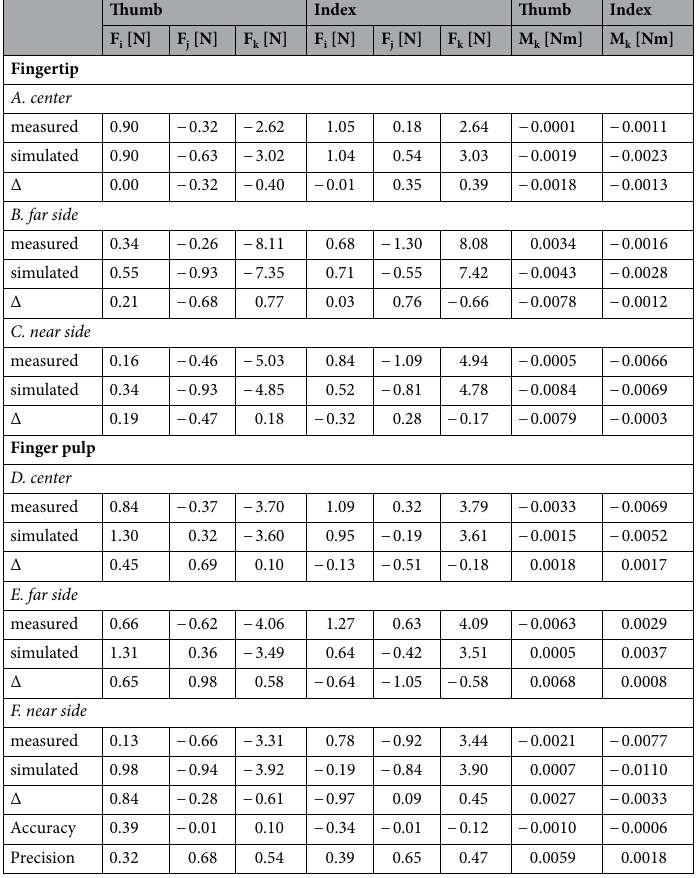
Table 2. Comparisons of measured and simulated forces and moments of six grasping conditions. F i , F j , and F k are the load (vertical), transverse and grip (normal) forces, respectively, represented in the object coordinate system. M k is the torsional moment at the center of pressure around a normal to the contact surface.